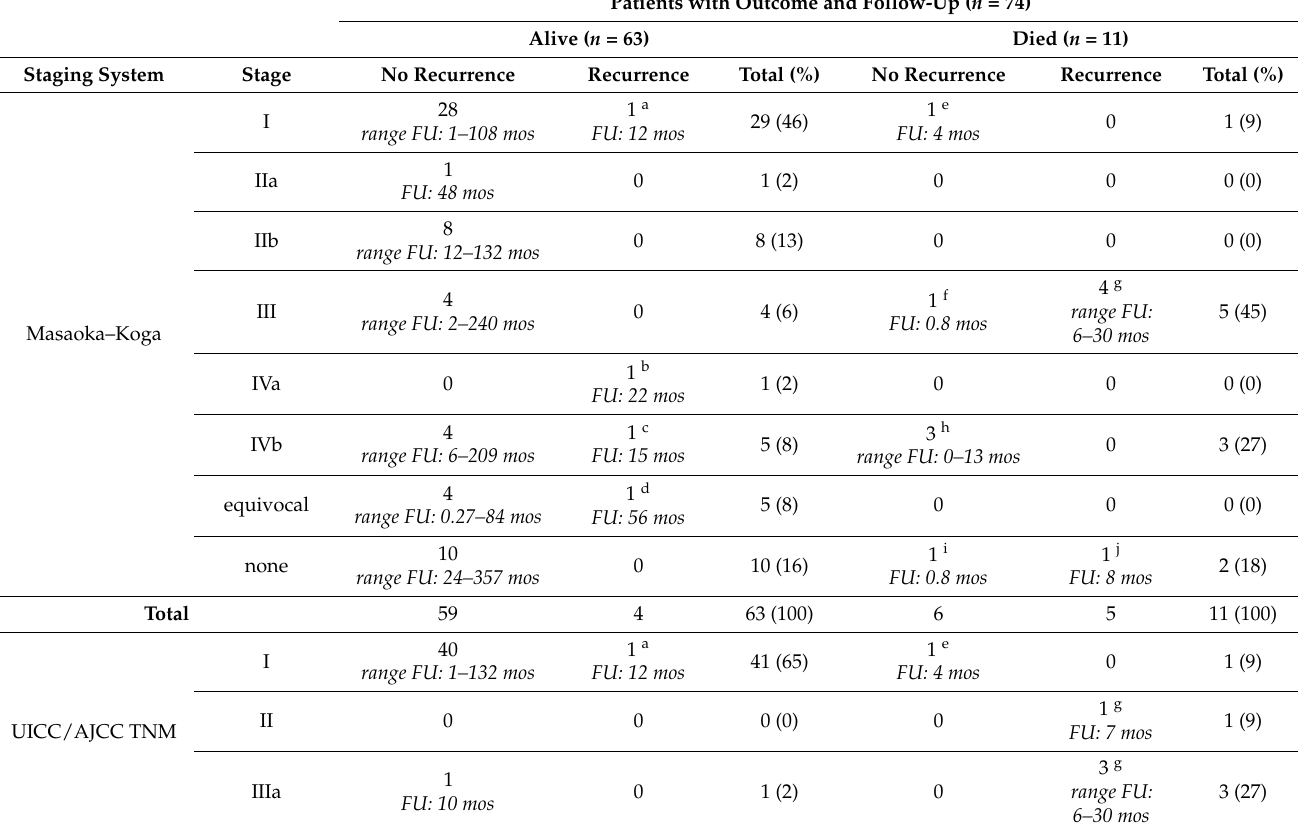
Table 1. Outcome by stage.